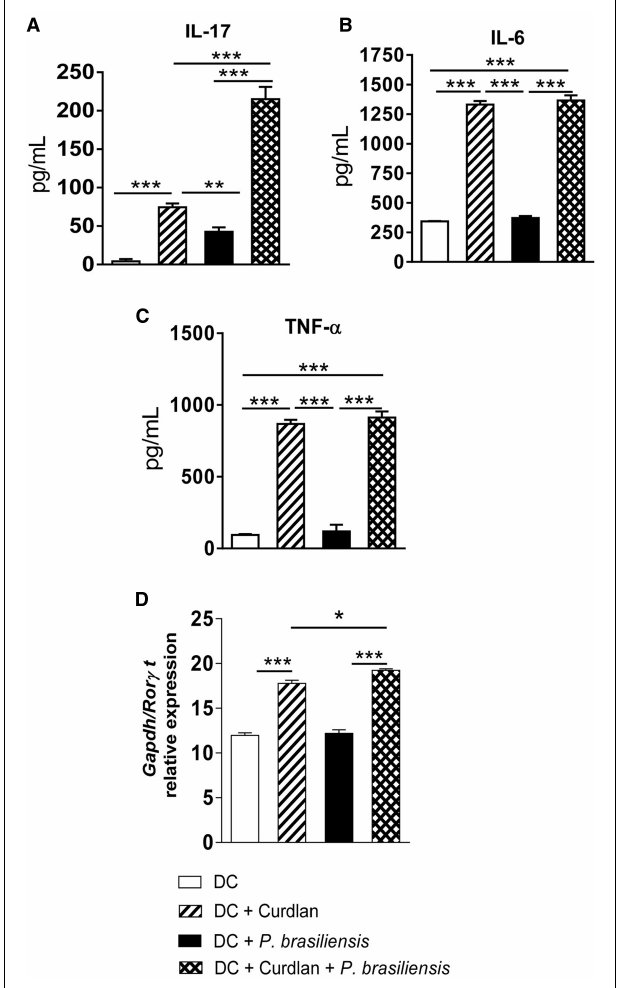
FIGURE 2 | Curdlan enhances the synthesis of IL-17, IL-6, and TNF- a concomitantly with increased mRNA expression of ROR g t. BMDCs of WT C57BL/6 mice were cultured as described in materials and methods. The cells were then treated or not with curdlan (100 m g/ml) for 30 min and infected with viable P. brasiliensis yeasts for 2 h. Splenic lymphocytes from uninfected C57BL/6 mice were co-cultivated with curdlan treated and untreated infected DCs. After 5 days, the supernatants were removed and used for cytokine measurements by ELISA (A–C) . Total RNA was extracted from cell cultures and ROR g t mRNA measured using TaqMan real-time PCR assay. All values were normalized to Glyceraldehyde-3-phosphate dehydrogenase (GAPDH) that was used as an internal control. (D) Data are means (cid:6) SD of five wells per group from two independent experiments (* P < 0.05; ** P < 0.01; *** P < 0.001).